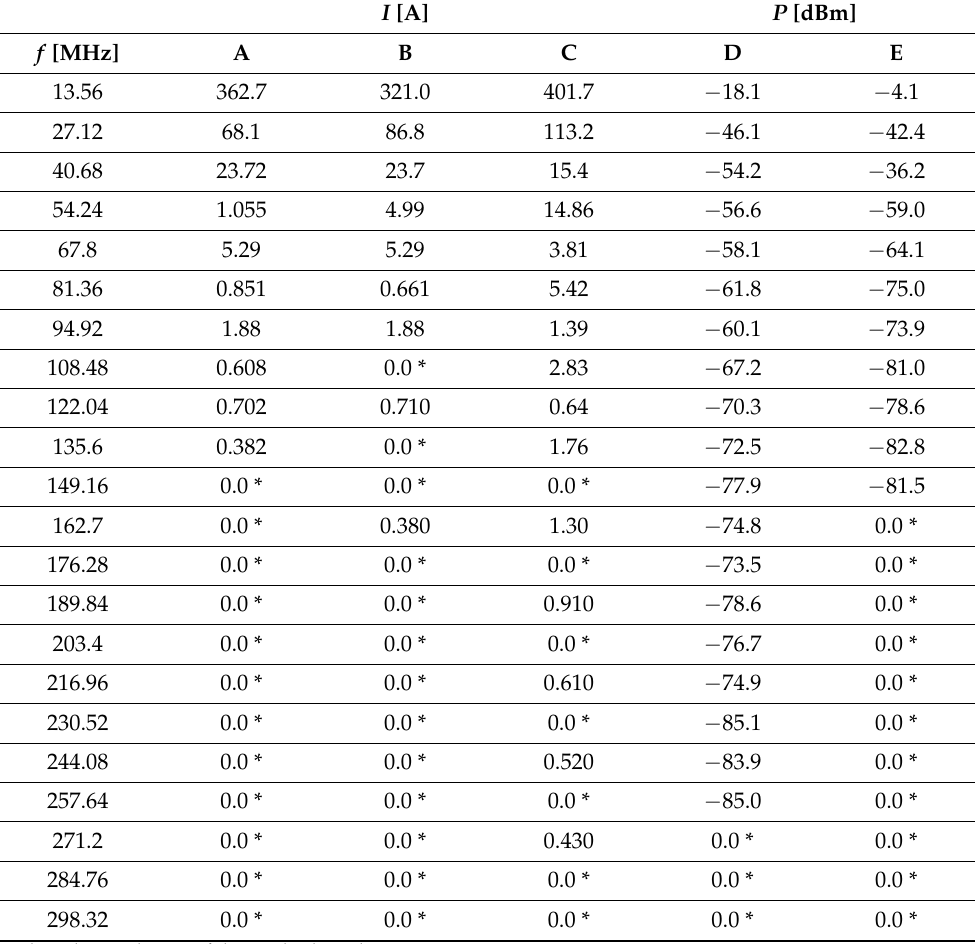
Table 2. The graphically displayed results of the numerical models (A — Figure 7a, B — Figure 7b, C — Figure 7c) and the experimental antenna measurements (D — Figure 9, E — Figure 10).